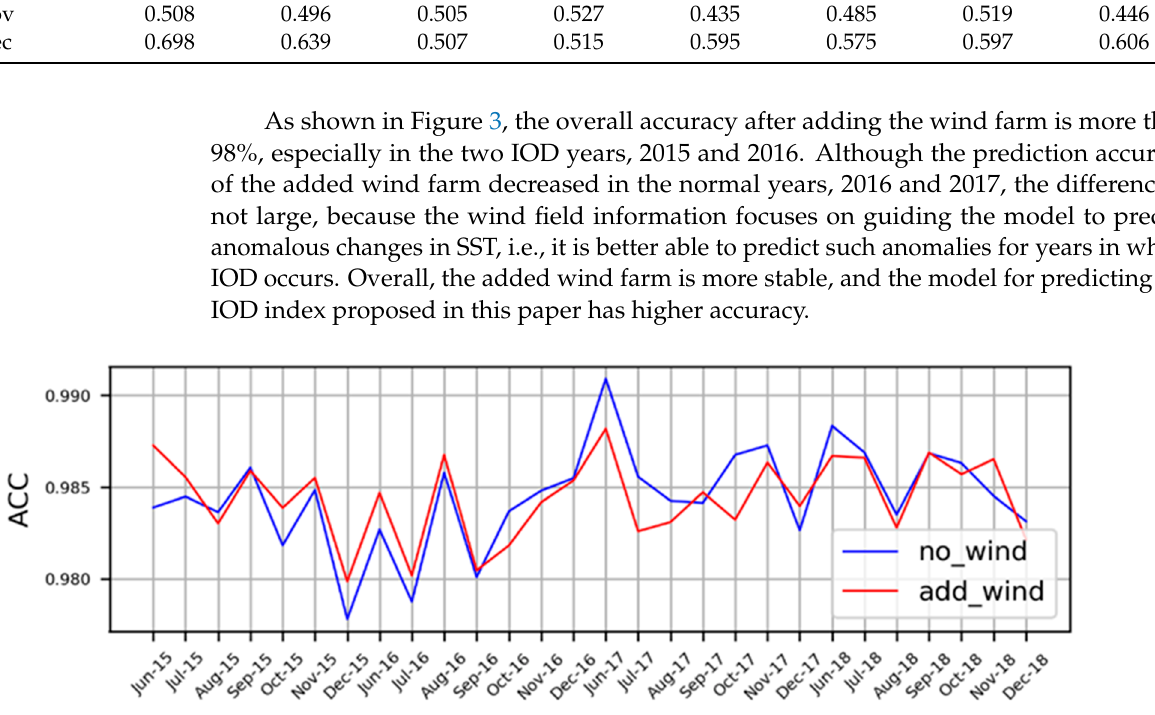
Table 2. RMSE of the no_wind convLSTM model and convLSTM model with wind field data.